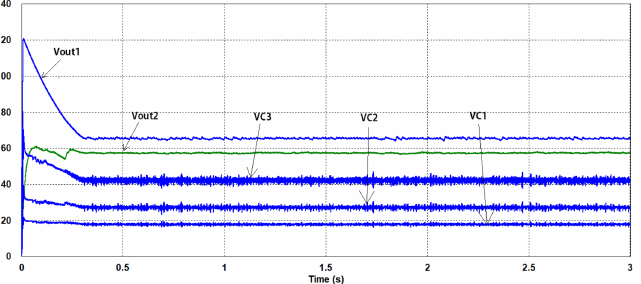
Figure 10. Capacitor voltage output in PSIM.